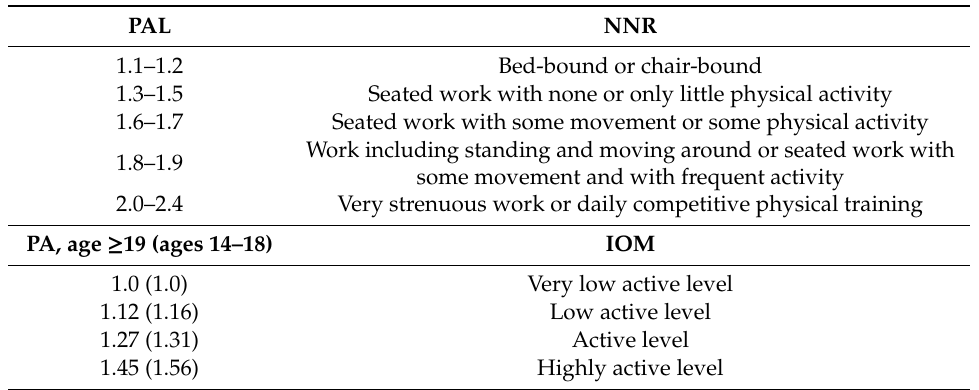
Table 3. Physical activity level (PAL) for use in equations for energy requirement recommended by NNR and Physical Activity Coe ffi cients (PA values) for use in equations for Energy requirement recommended by IOM.